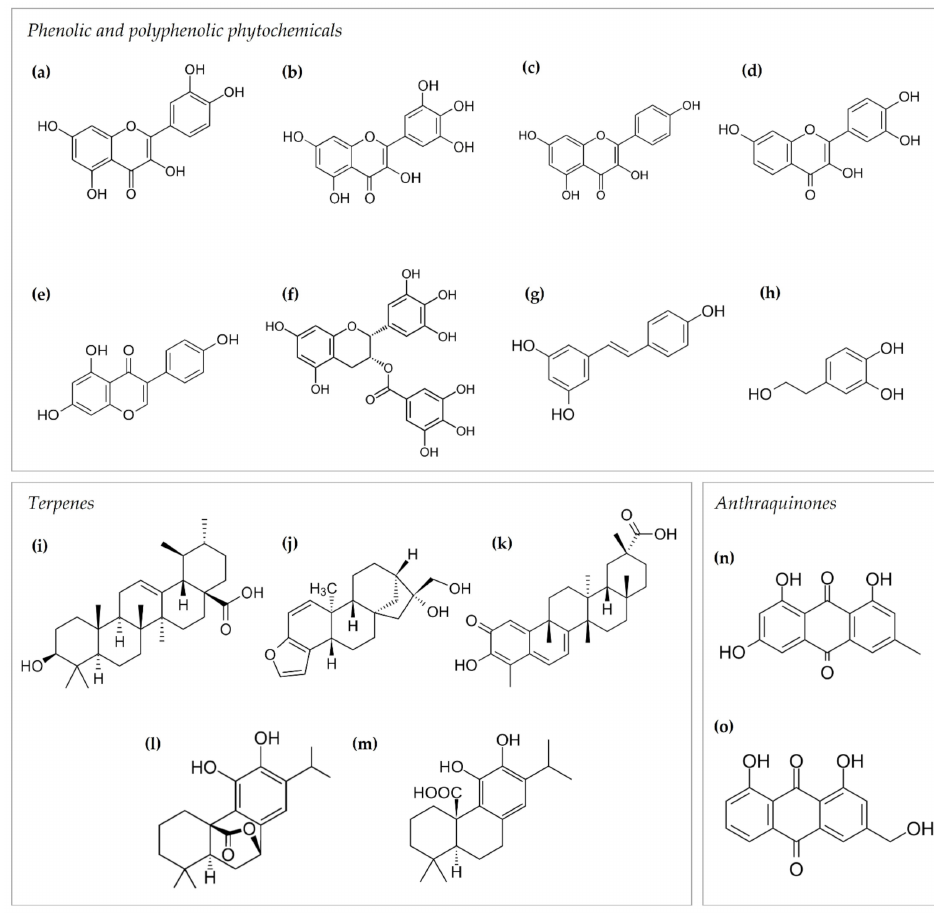
Figure 3. Chemical structures of the phenolic and polyphenolic phytochemicals ( a ) quercetin, ( b ) myricetin, ( c ) kaempferol, ( d ) fisetin, ( e ) genistein, ( f ) epigallocatechin-3-gallate, ( g ) resvera- trol, and ( h ) hydroxytyrosol; the terpenes ( i ) ursolic acid, ( j ) kahweol, ( k ) celastrol, ( l ) carnosol, and ( m ) carnosic acid; and the anthraquinones ( n ) emodin and ( o )